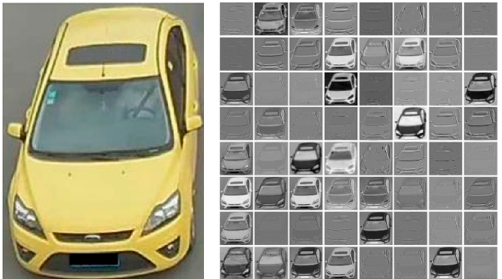
Figure 3. Original image of the vehicle and global shallow characteristics.